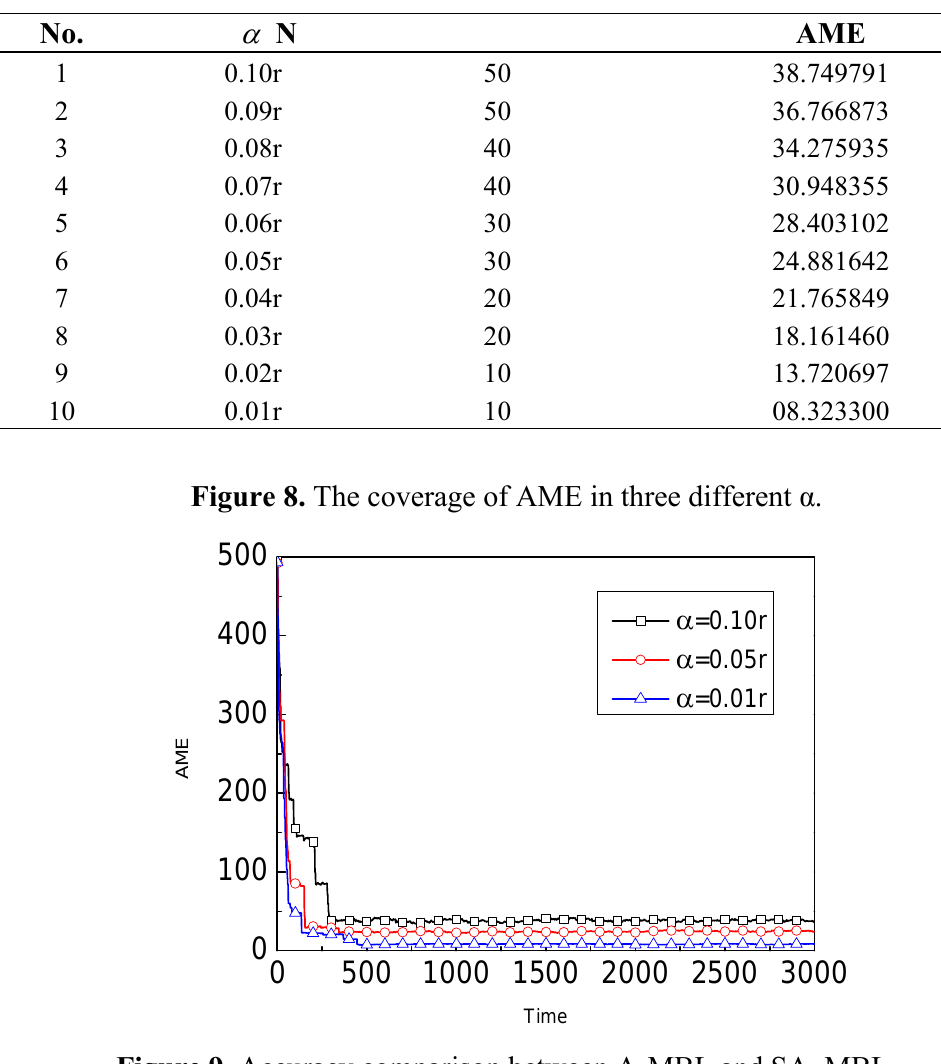
Table 4. Parameters for ten different values of AME.